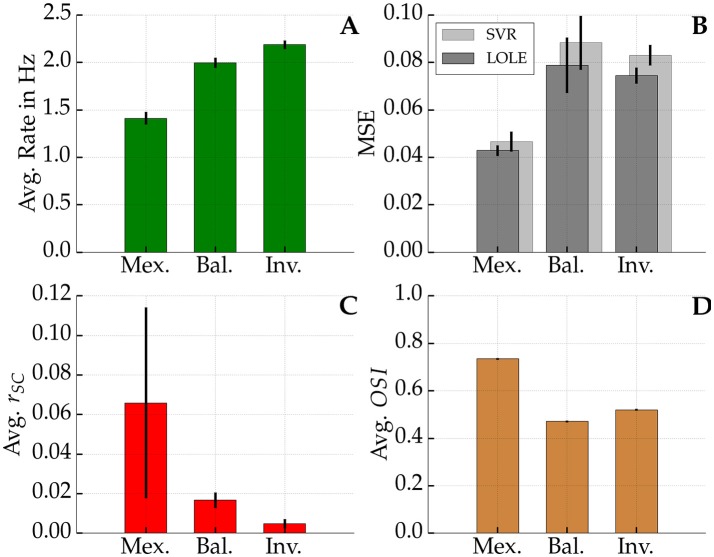
Firing rate, MSE, rSC, and OSI. Top left (A): Average network firing rate averaged over all excitatory neurons. Top right (B): In dark gray the average mean squared error (MSE) of the linear decoder is shown whereas in light gray one sees the average MSE of the best Support Vector Regression (SVR). Bottom left (C): Average noise correlation among pairs of neurons at most 13.3 px apart for a 3 s time window. Bottom right (D): Average Orientation Selectivity Index (OSI) among all neurons in the networks. Black bars show the standard deviation across 10 network realizations per profile in each sub-figure. In (D) standard deviations are so low that the black bars are not visible. Network parameters as in Figure 8.